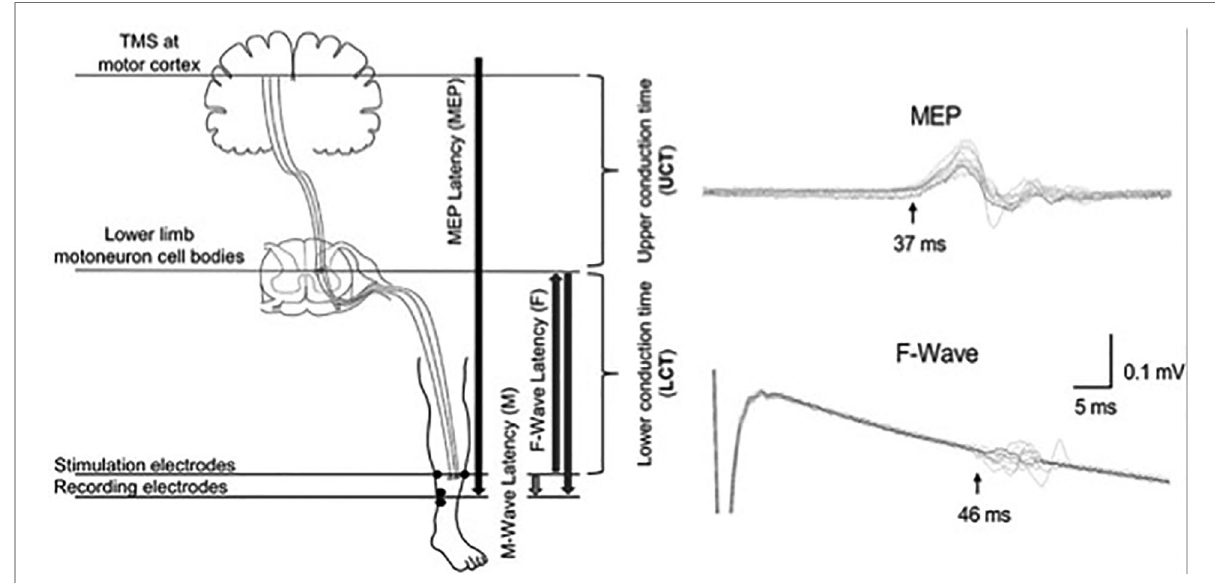
FIGURE 2 Calculation of the conduction times for paired associative stimulation. Use of upper conduction time (central motor conduction time) and lower conduction time (peripheral conduction time) for targeting the stimulation to lower limb motoneuron cell bodies. Use of latencies of MEP, F- wave and M-wave for precise calculations of the conduction times [Reprinted from Fok et al., 2020 (64); reprint permitted under Creative Commons Attribution License; CC BY].